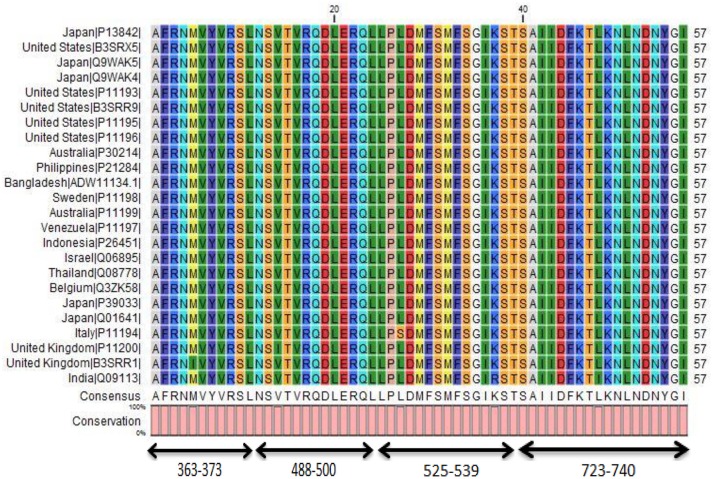
Conserved region in 24 different strains of Human Rotavirus A. Four conserved regions of more than 10 amino acids were found on multiple sequence alignment. The conserved region “SAIIDFKTLKNLNDNYGI” showed higher antigenic score which allowed to predict some probable candidates for peptide based vaccine design.